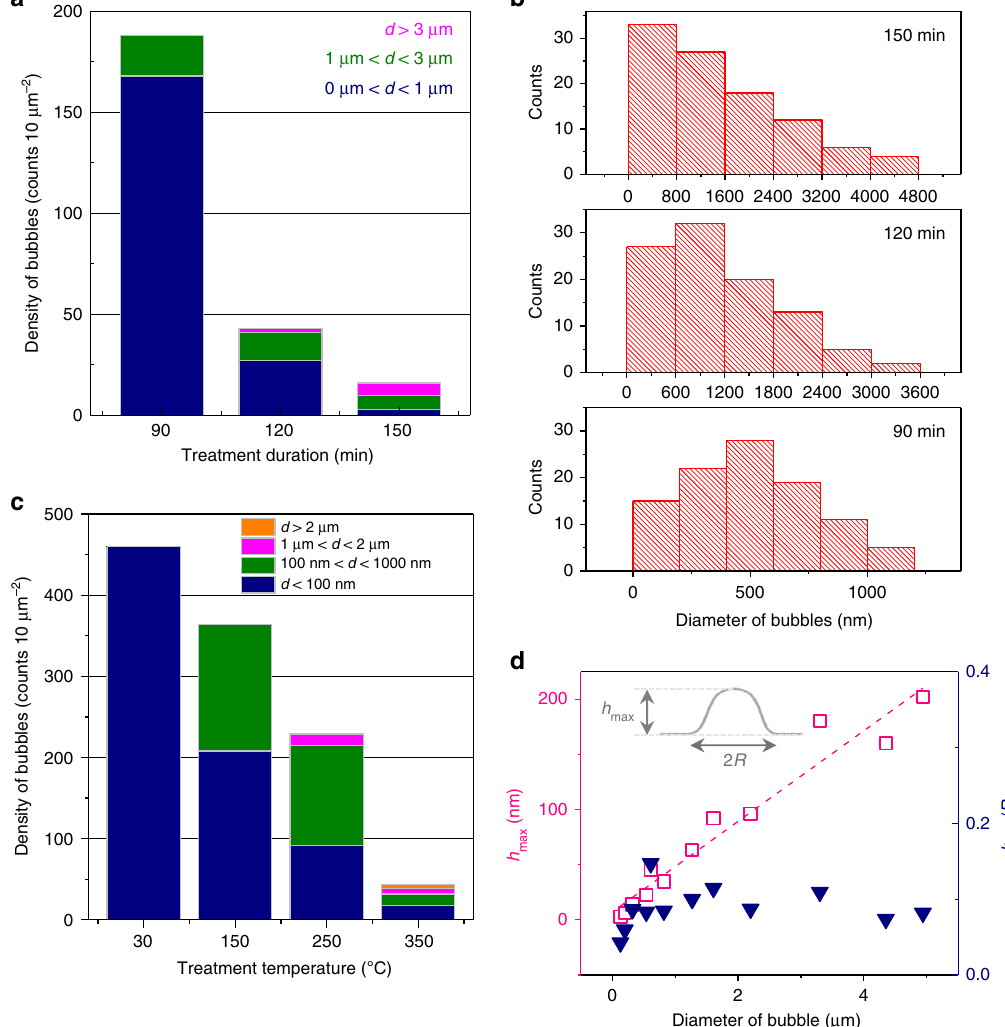
Fig. 3 In fl uence of the plasma treatment duration and sample temperature on the dimensions of the bubbles. a Density and relative fractions of h -BN bubbles within three diameter ranges (0 – 1 μ m, 1 – 3 μ m, and >3 μ m) produced by different H-plasma treatment durations; all samples were treated under the typical experimental conditions (100 W RF, 350 °C, 3 sccm H 2 , ~3 Pa). b Dimension distributions of the h -BN bubbles produced after H-plasma treatment for 90, 120, and 150 min. c Density and relative fractions of h -BN bubbles within four diameter ranges (<100 nm, 0.1 – 1 μ m, 1 – 2 μ m, and >2 μ m) produced from treatment at different sample temperatures (30, 150, 250 and 350 °C); the other conditions were not changed (100 W RF, 120 minutes, 3 sccm H 2 , ~3 Pa). d h max of the bubbles produced by the H-plasma and the aspect ratio of the bubbles with respect to the bubble diameter. The